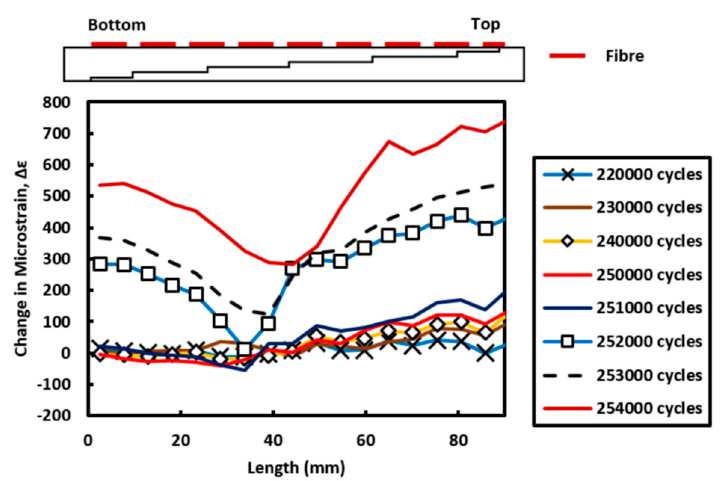
Figure 12. Difference in strain measurement along the bonded fibre (Fibre 1) at 50,000 cycles before failure occurs.